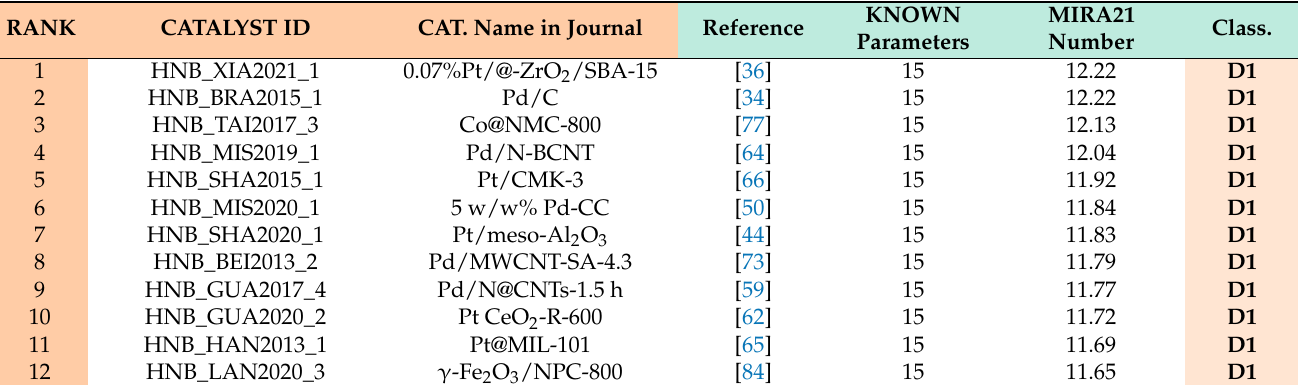
Figure 11. Distribution of catalysts according to classification (D1, Q1, Q2, Q3, Q4) system.